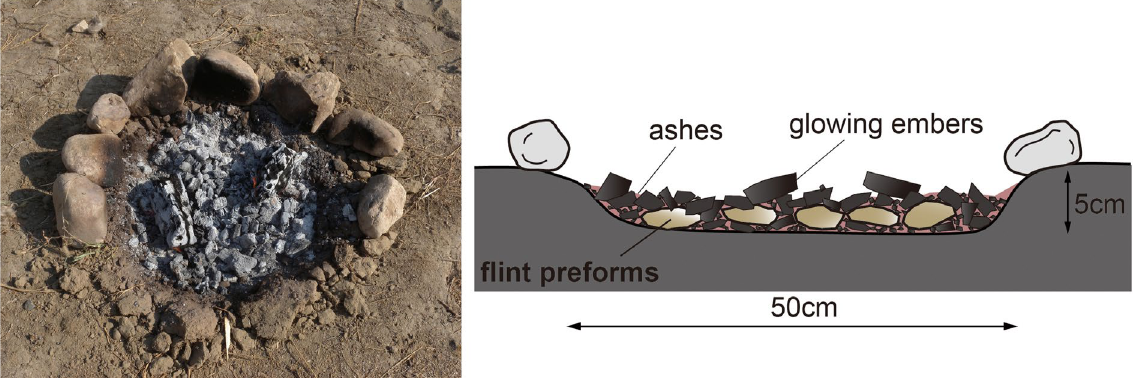
Figure 8. Heat treatment using open fire. Left: The samples are covered with embers. Right: Schematic diagram of the heating